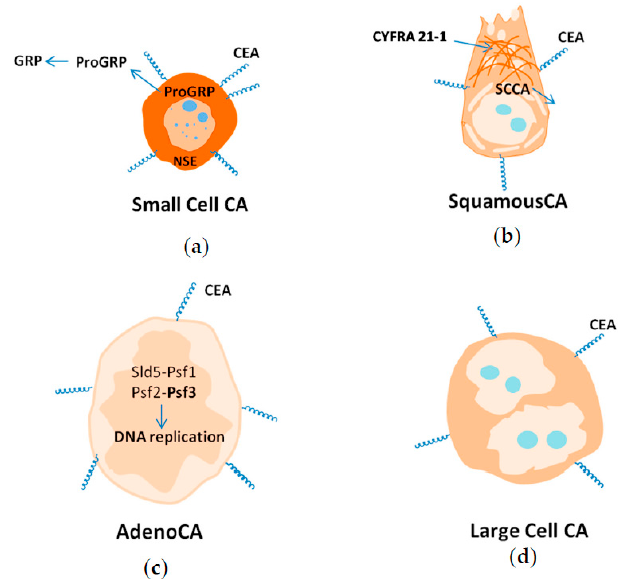
Figure 5. Biomarkers of Small Cell Lung Cancer ( a ), Squamous Lung Cancer ( b ), Lung Adenocarcinoma ( c ), Large Cell Lung Cancer ( d ). GRP: gastrin-releasing peptide ; CEA: ( c ), Large Cell Lung Cancer ( d ). GRP: gastrin-releasing peptide ; CEA: carcinoembryonic antigen ; NSE: carcinoembryonic antigen ; NSE: neuron specific enolase; SCCA: squamous cell carcinoma antigen ; neuron specific enolase; SCCA: squamous cell carcinoma antigen ; CYFRA 21-1: cytokeratins ; Sid5 : CYFRA 21-1: cytokeratins ; Sid5 : Systemic RNA interference defective protein 5 ; Psf1-Psf3: GINS Systemic RNA interference defective protein 5 ; Psf1-Psf3: GINS complex subunits complex subunits 1-3.